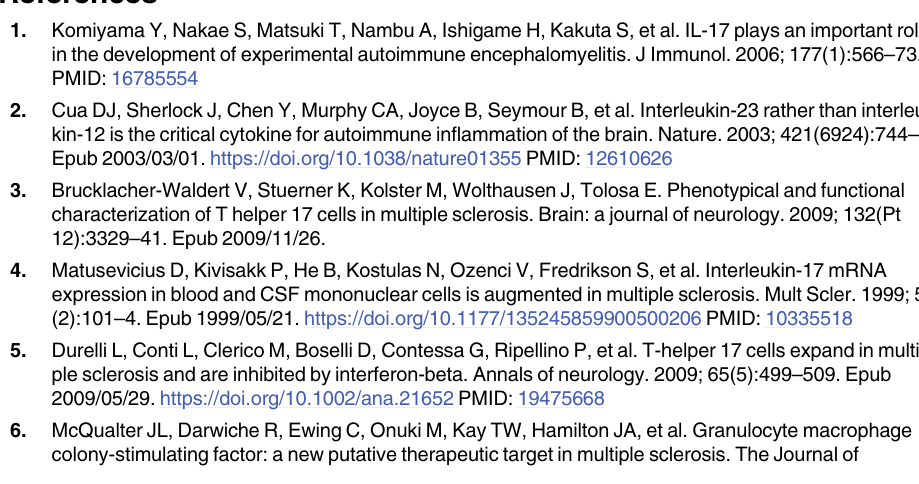
relapsing MS (n = 15) and HC (n = 10). (C) IL-24 (Relapsing MS: n = 14, Stable MS: n = 10, HC: n = 13) and (D) IL-26 (Relapsing MS: n = 14, Stable MS: n = 10, HC: n = 13) mRNA expressions after 4h of PMA/ionomycin stimulation. (E) IL-26 concentration was quantified by ELISA in serum (Relapsing MS: n = 10, Stable MS: n = 10, HC: n = 10). (TIFF) S3 Fig. GM-CSF, IL-22 and CD39-expressing Th17 cells from relapsing and stable MS patients and from healthy controls (HC). PBMCs were stained for IL-17, GM-CSF, IL-22, CD39, CD3 and CD4 after 4h stimulation by PMA/ionomycin in the presence of a protein transport inhibitor and analysed by flow cytometry. Scatter dot plots illustrate the percentage of GM-CSF +, IL-22 + and CD39 + cells within the IL-17 + CD4 + T cell population. The horizontal lines of scatter plots represent the median value in all subgroups.